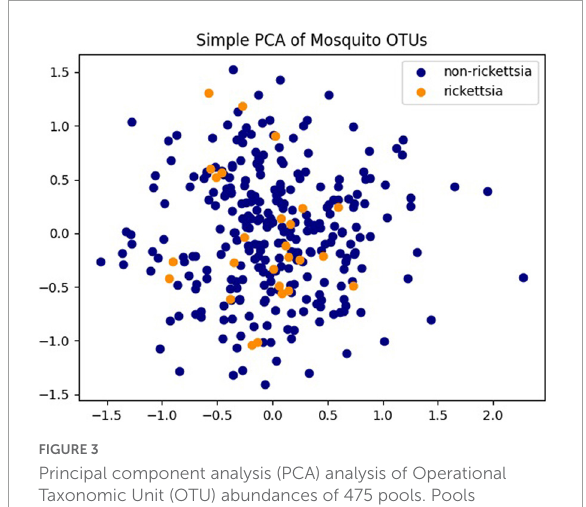
FIGURE3 Principal component analysis (PCA) analysis of Operational Taxonomic Unit (OTU) abundances of 475 pools. Pools containing Rickettsia spp. are colored in orange and pools without Rickettsia spp. identified are colored in dark